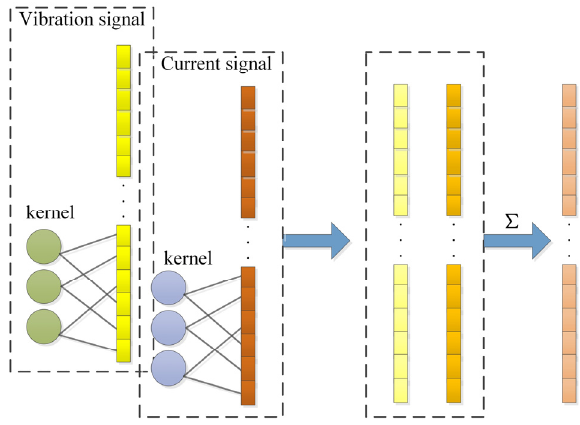
Figure 3. Multi-signal convolution process.